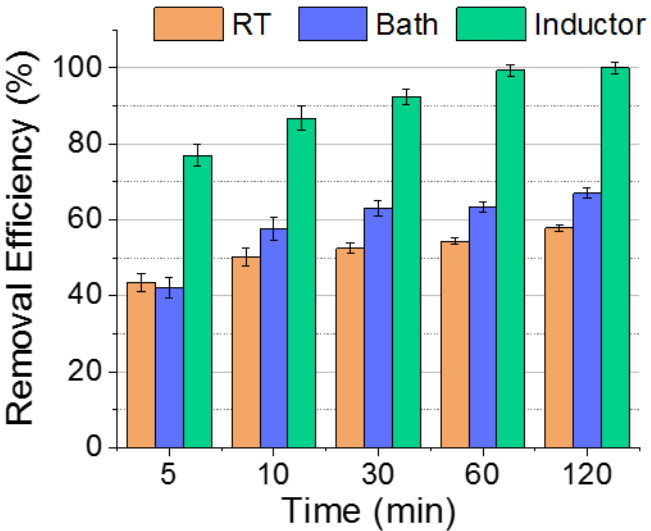
Figure 6. Removal e ffi ciency of bare nanoparticles when the sorption experiment has been performed Figure 6. Removal efficiency of bare nanoparticles when the sorption experiment has been performed at room temperature, and at 60 ◦ C in a thermal bath and under inductor heater with a 25 mg / L of at room temperature, and at 60 °C in a thermal bath and under inductor heater with a 25 mg/L of pollutant pollutant concentration.